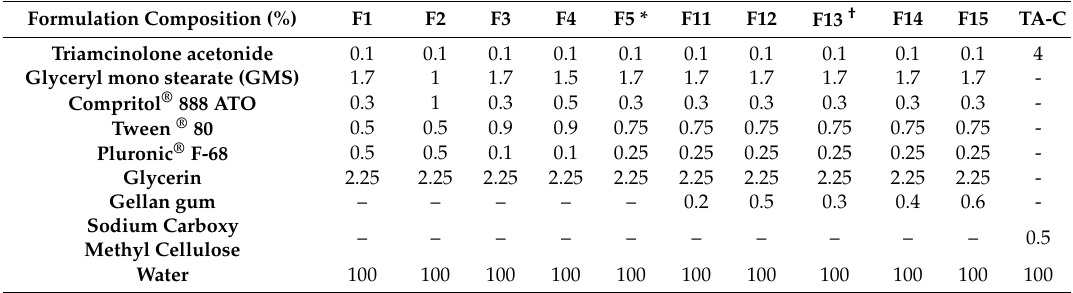
Table 1. Composition of triamcinolone acetonide loaded solid lipid nanoparticles and in situ gels. Formulation Composition